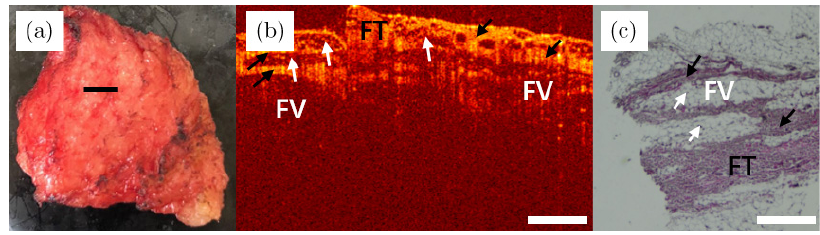
Fig. 5. Images of lipoma. (a) Photo of the excised tissue specimen. (b) An OCT image of lipoma. (c) Its corresponding histo- pathological image. FT: ¯brous tissue and FV: fat vesicle.